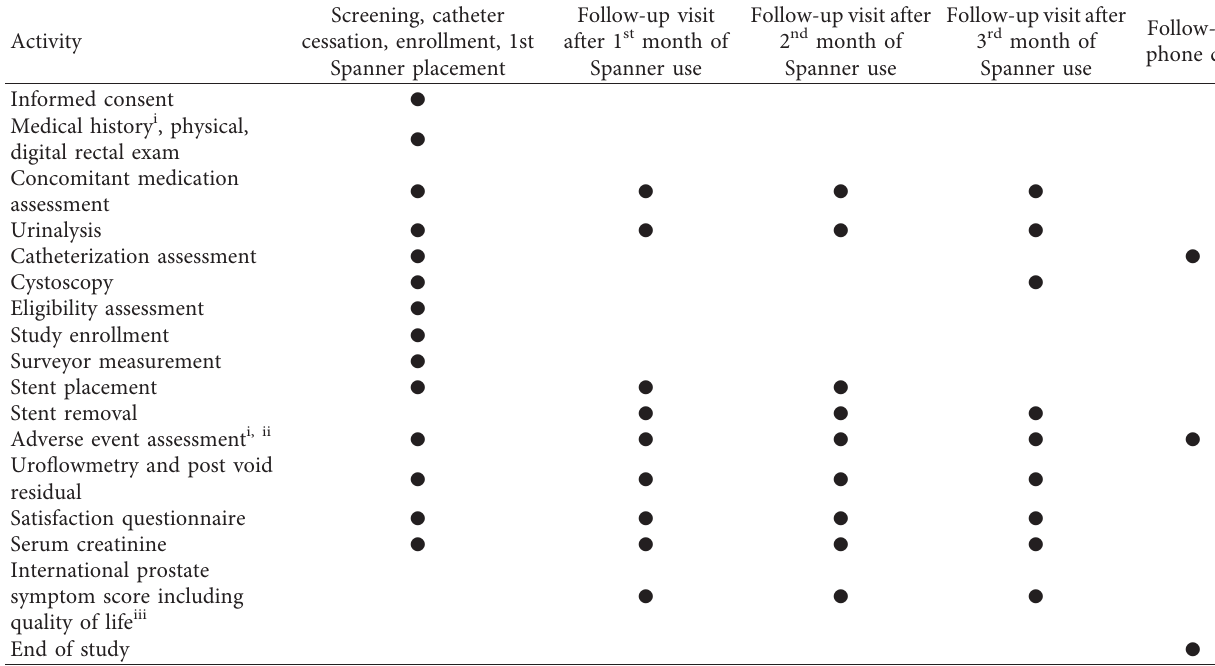
Table 1: Study activities.